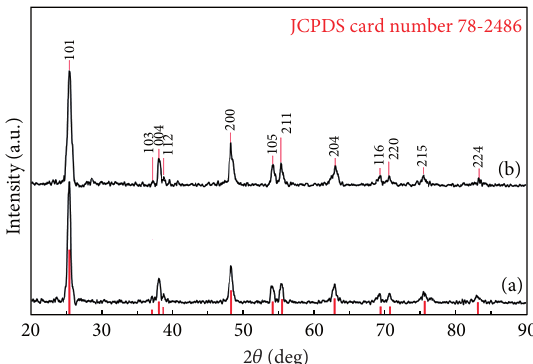
F 3: X-ray diffraction patterns for samples A and B of TNPs ((a) and